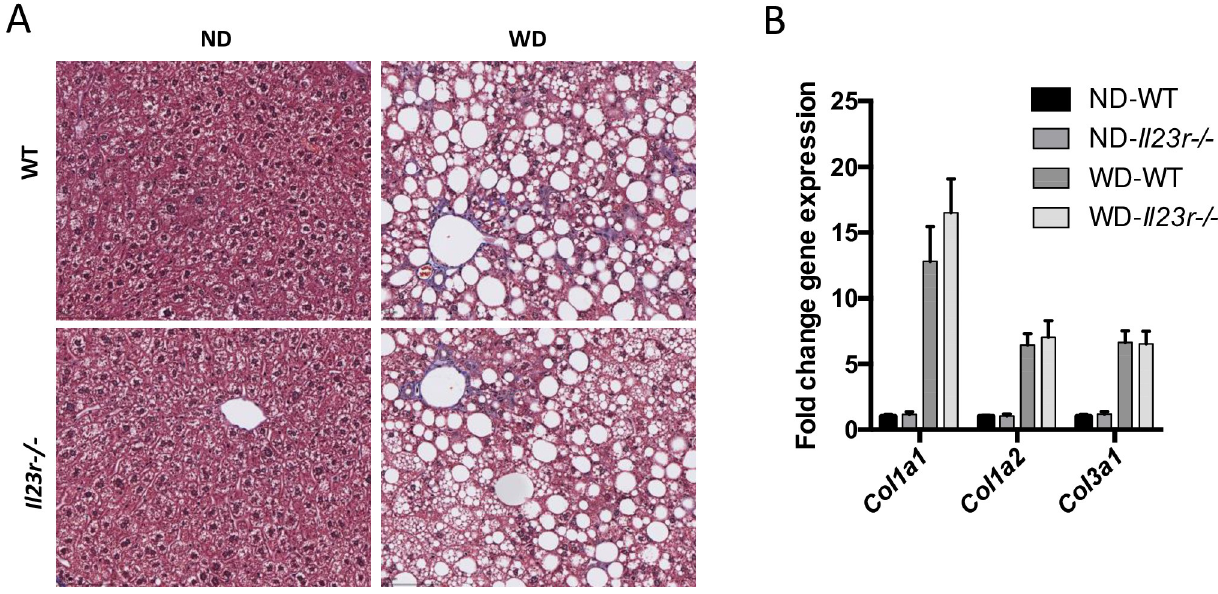
Fig 4. IL-23 signaling does not contribute to WD-induced liver fibrosis. Trichrome staining images of livers from WT and Il23r -/- mice on ND or WD (A). Liver mRNA levels of Col1a1 , Col1a2 , and Col3a1 . Groups: ND WT n = 5, ND Il23r -/- n = 5, WD WT n = 7, WD Il23r -/- n = 7.